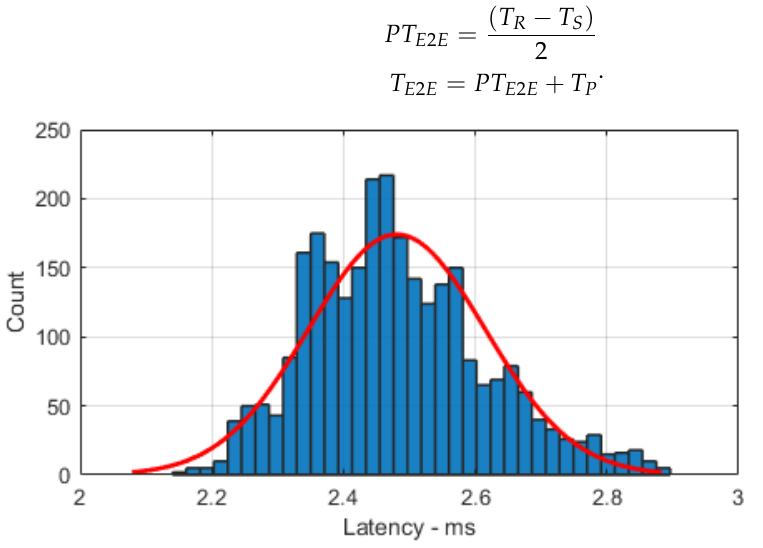
Figure 1. End to End latency